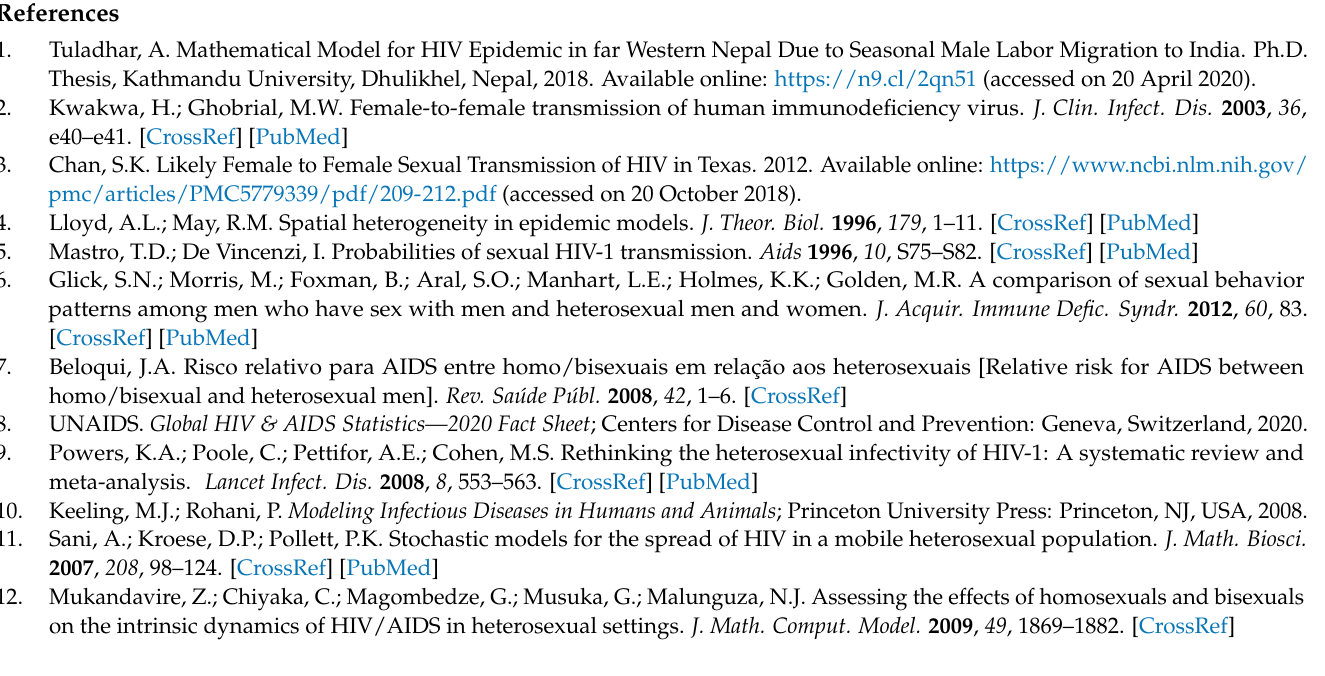
< 1 and whenever case b3 of Table A1 There is no EE if R het 0